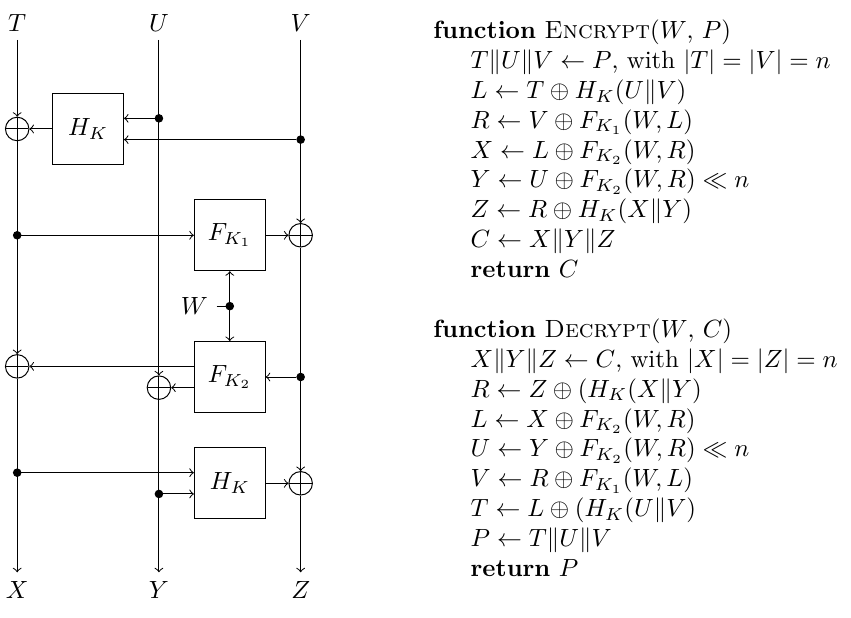
Figure 3: Docked-double-decker tweakable wide block cipher. The parsing of P into states T, U, V , where | T | = | V | = n is not